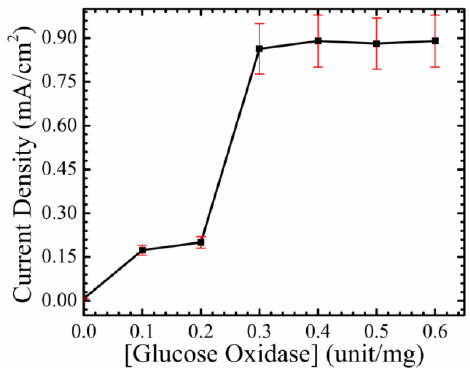
Figure 3. The current density as a function of glucose oxidase concentrations, in order to optimize the concentration of the enzyme GO x for the working electrode immobilization condition.